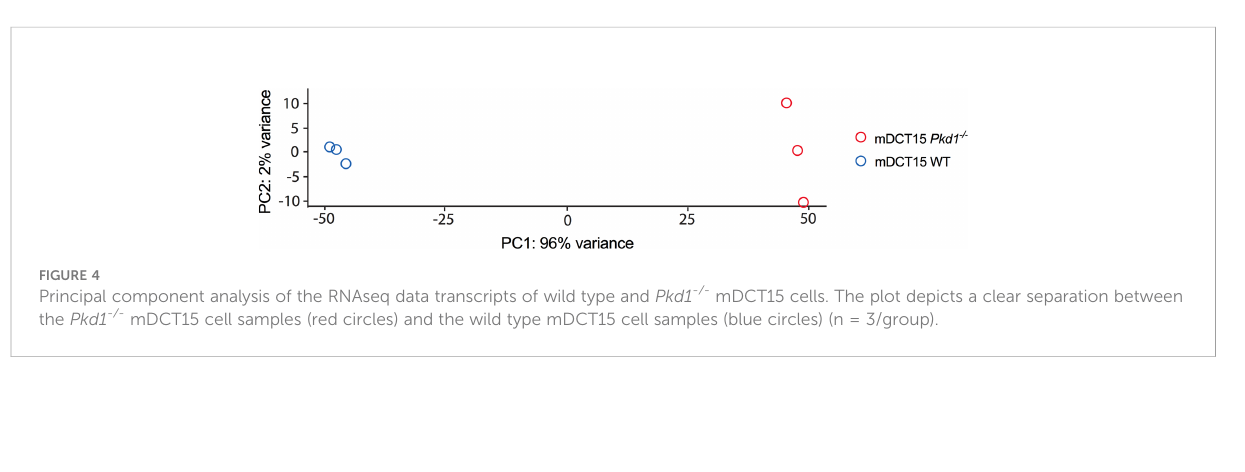
(Figure 5A) and Smpd3 (+ 38%) (Figure 5B) in Pkd1 -/- mDCT15